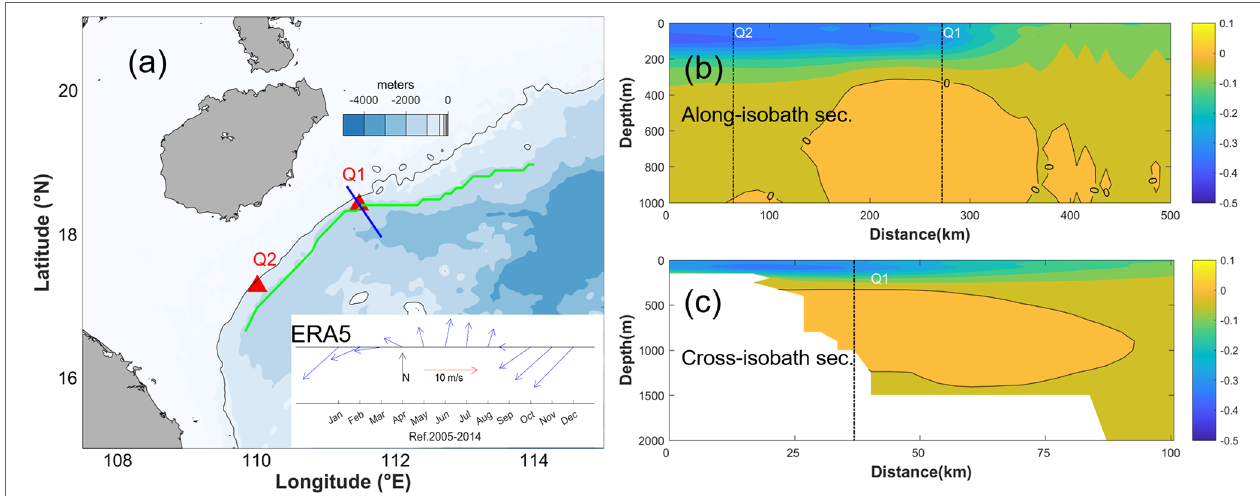
FIGURE 7 | (A) Transects for the flow field from the HYCOM output along the 1000-m isobath (green curve) and cross-isobath (blue curve); the inset at the lower right is the stick diagram of monthly mean wind velocity averaged over ten years (2005-2014) in the study region. Mean along-slope current (m/s) from HYCOM output along the 1000-m isobath (B) and cross-isobath (C) in the months (from October to March) of winter monsoon for the years from 2005 to 2014. The black contours in panels B and C indicate zero flow speed; the along-isobath (off-isobath) distances of mooring stations Q1 and Q2 are indicated with black dotted lines.